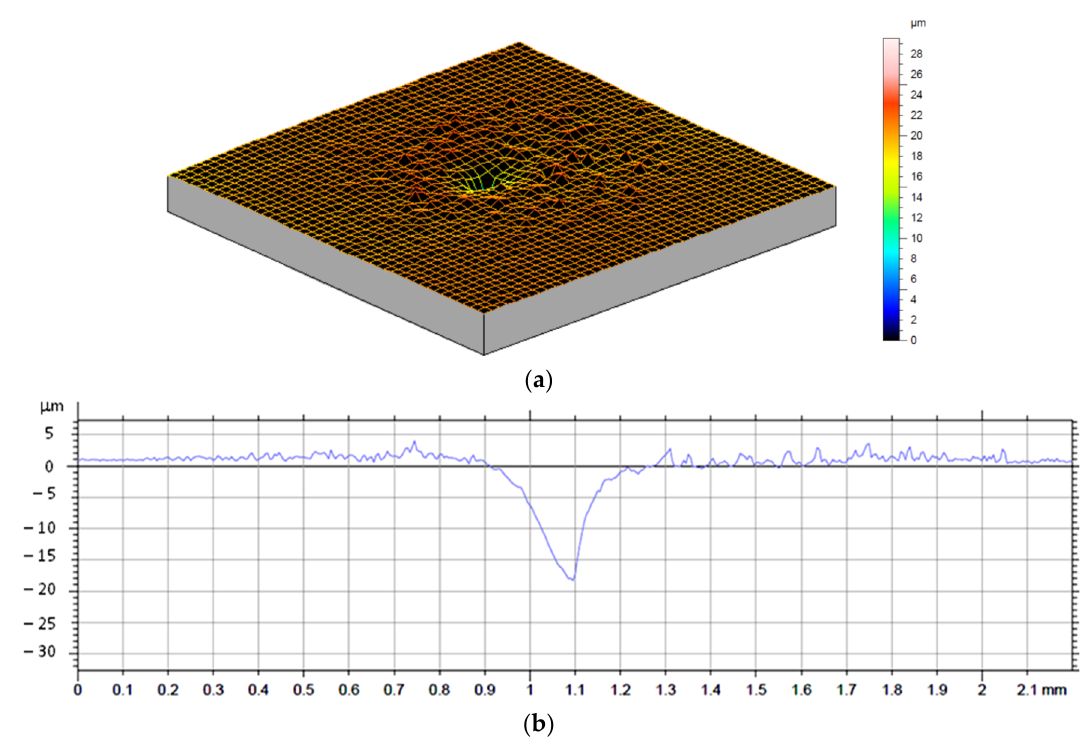
Figure 6. ( a ) The morphology of the laser irradiated zone measured through a 3D surface analyzer. A level profile of the crater determined from the image in ( a ) is displayed in ( b ).